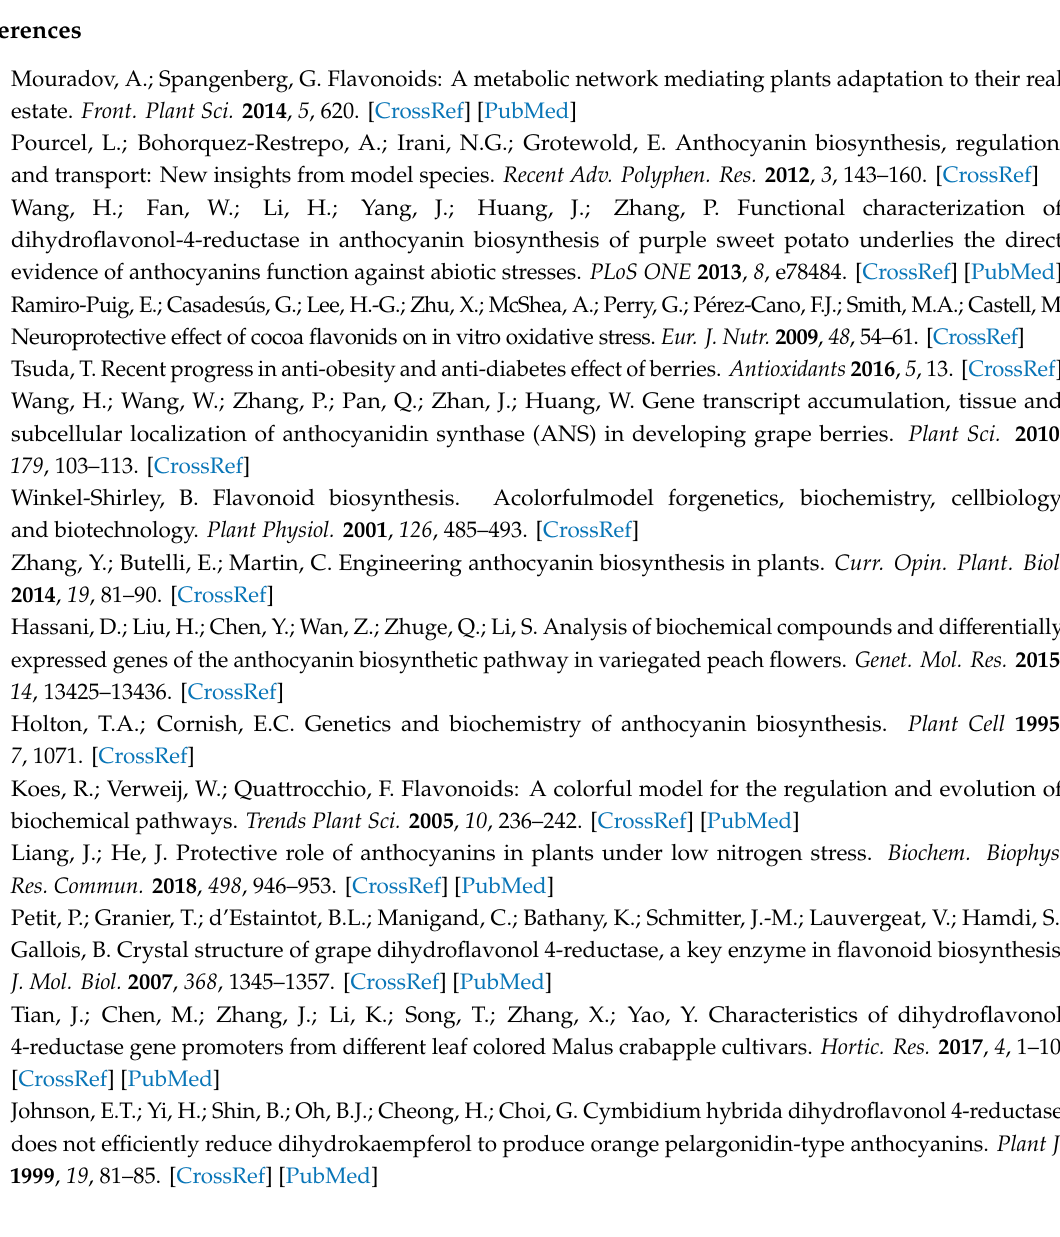
Figure S1: PCR identification for positive tobaccos, Table S1: Primer list and